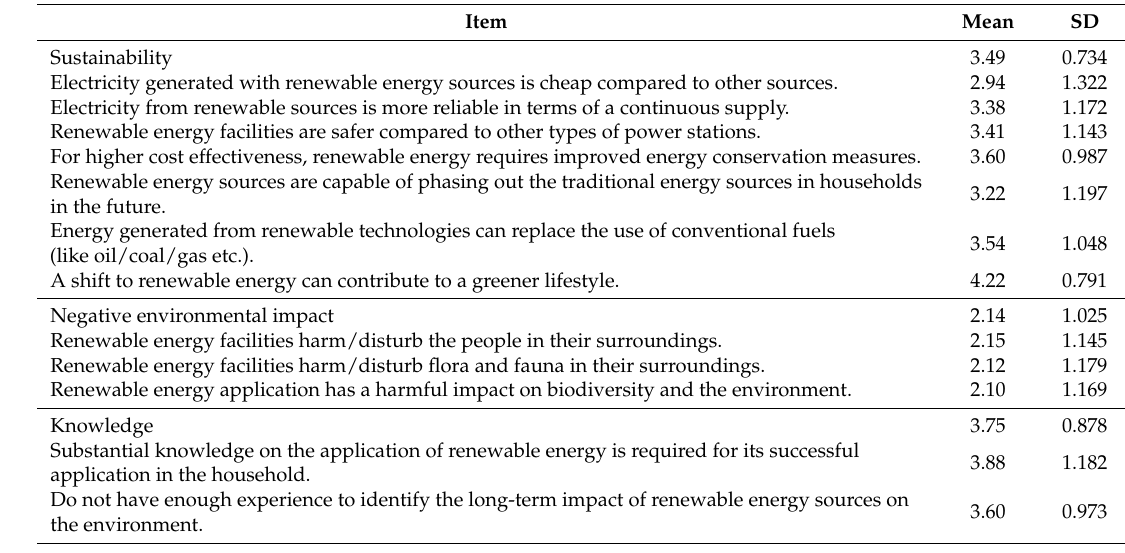
Table 3. Perception on renewable energy sources.